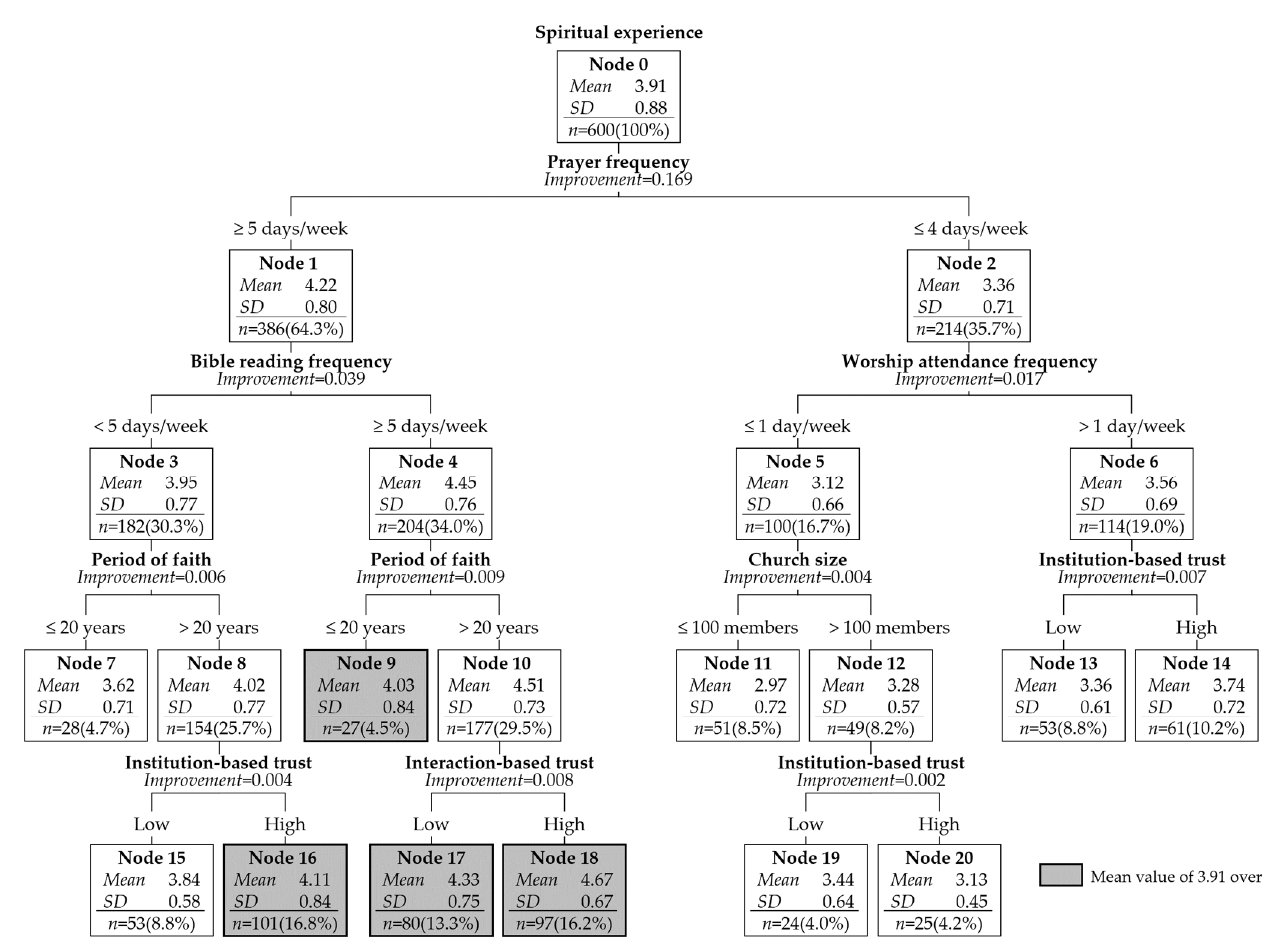
Figure 1. Structure of decision tree for spiritual experience.